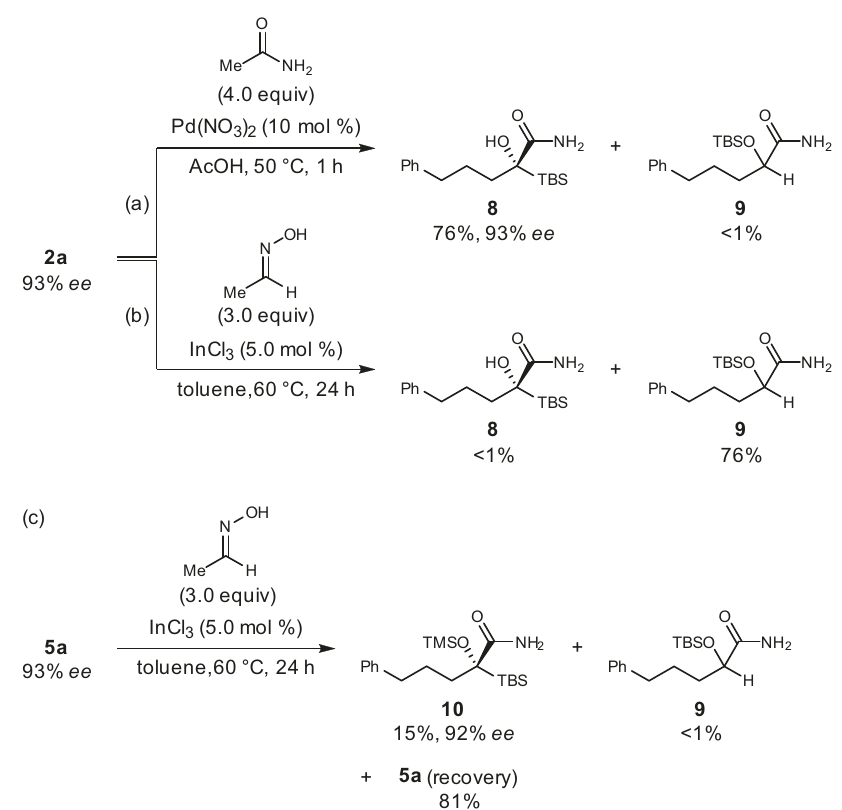
Fig. 9 Hydration of 2a and 5a. a Hydration of 2a using acetamide with palladium nitrate. b Hydration of 2a using acetaldoxime with indium chloride. c Hydration of 5a using acetaldoxime with indium